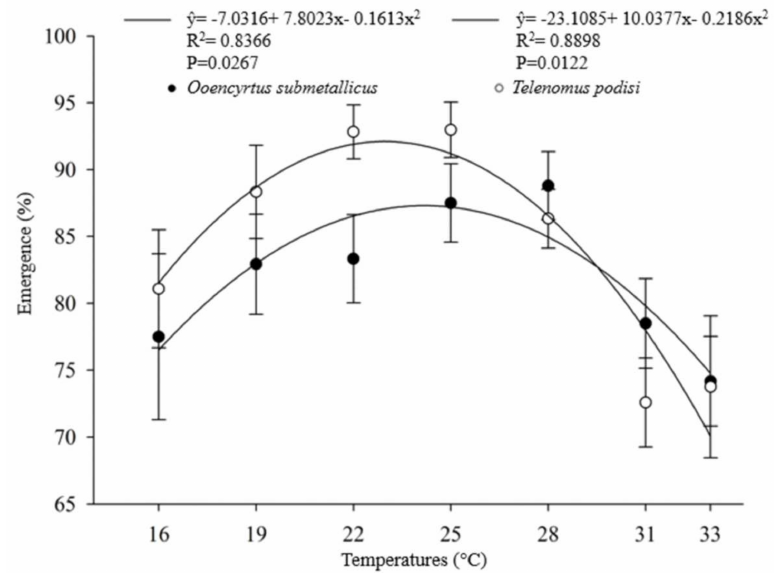
Figure 2. Emergence (%) (mean ± EP) of Ooencyrtus submetallicus and Telenomus podisi in Euschistus heros eggs at different temperatures.